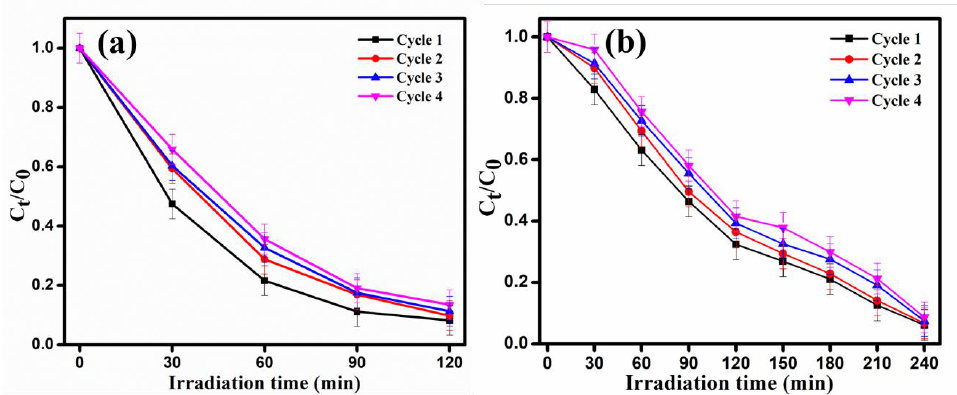
Figure 12. Reusability of CLMO catalyst for photodegradation of ( a ) NP and ( b ) BPA pollutants.